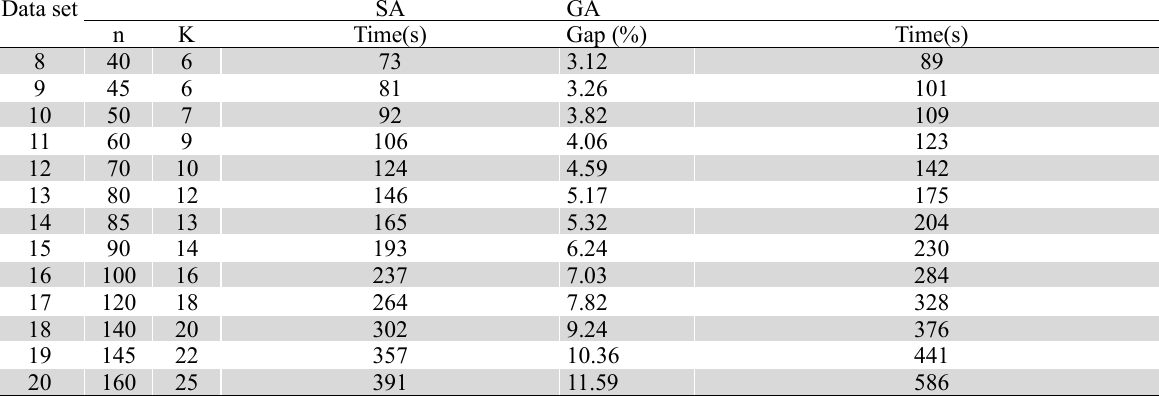
Average relative gaps and CPU Time for large-sized problems. Data set